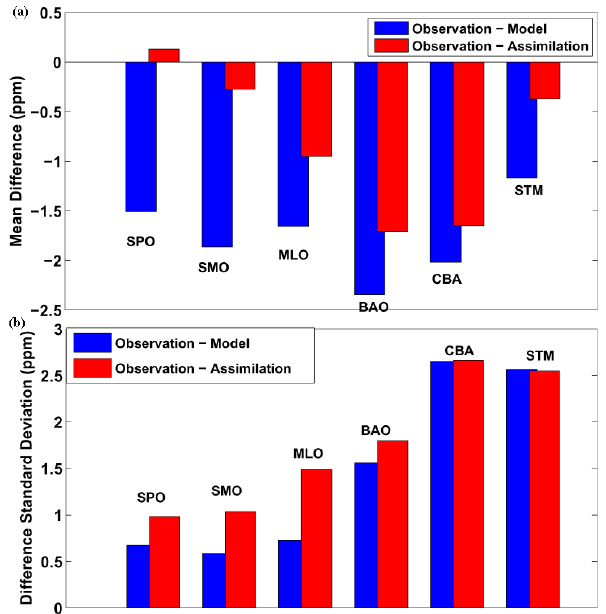
Fig. 5. Mean (a) and standard deviation (b) differences (O − M or O − A) between NOAA/ESRL/GMD cooperative air sampling net- work and model (blue) or analysis (red) fields interpolated to obser- vation locations. The sites used here are the same as those in Fig. 4, and are ordered from south to north.